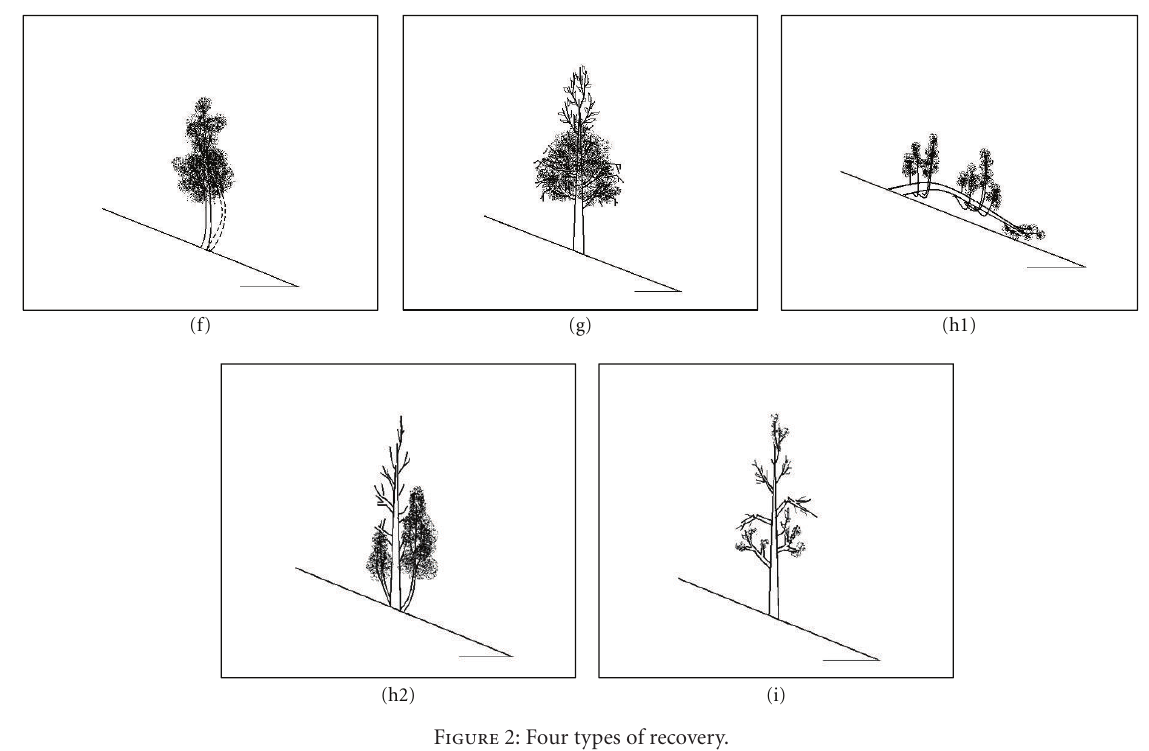
Figure 2: Four types of